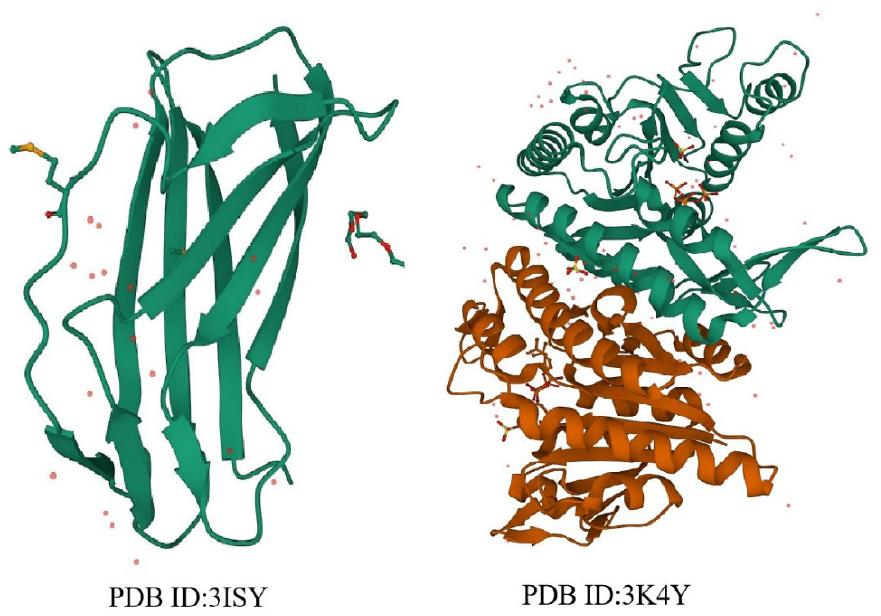
Figure 2. Three-dimensional structure of isopentenyl pyrophosphate isomerase. (PDB ID: 3ISY) Crystal structure of an intracellular proteinase from bacillus subtilis. (PDB ID: 3K4Y) Crystal structure of Isopentenyl Phosphate Kinase from M. jannaschii in complex with IPP